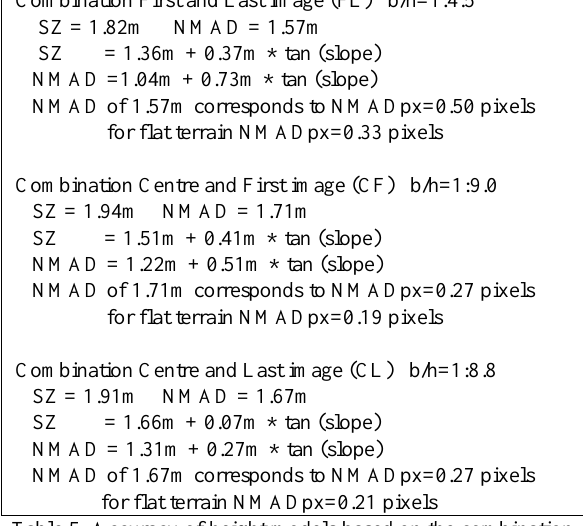
Figure 12. Colour coded height differences CF against reference DTM